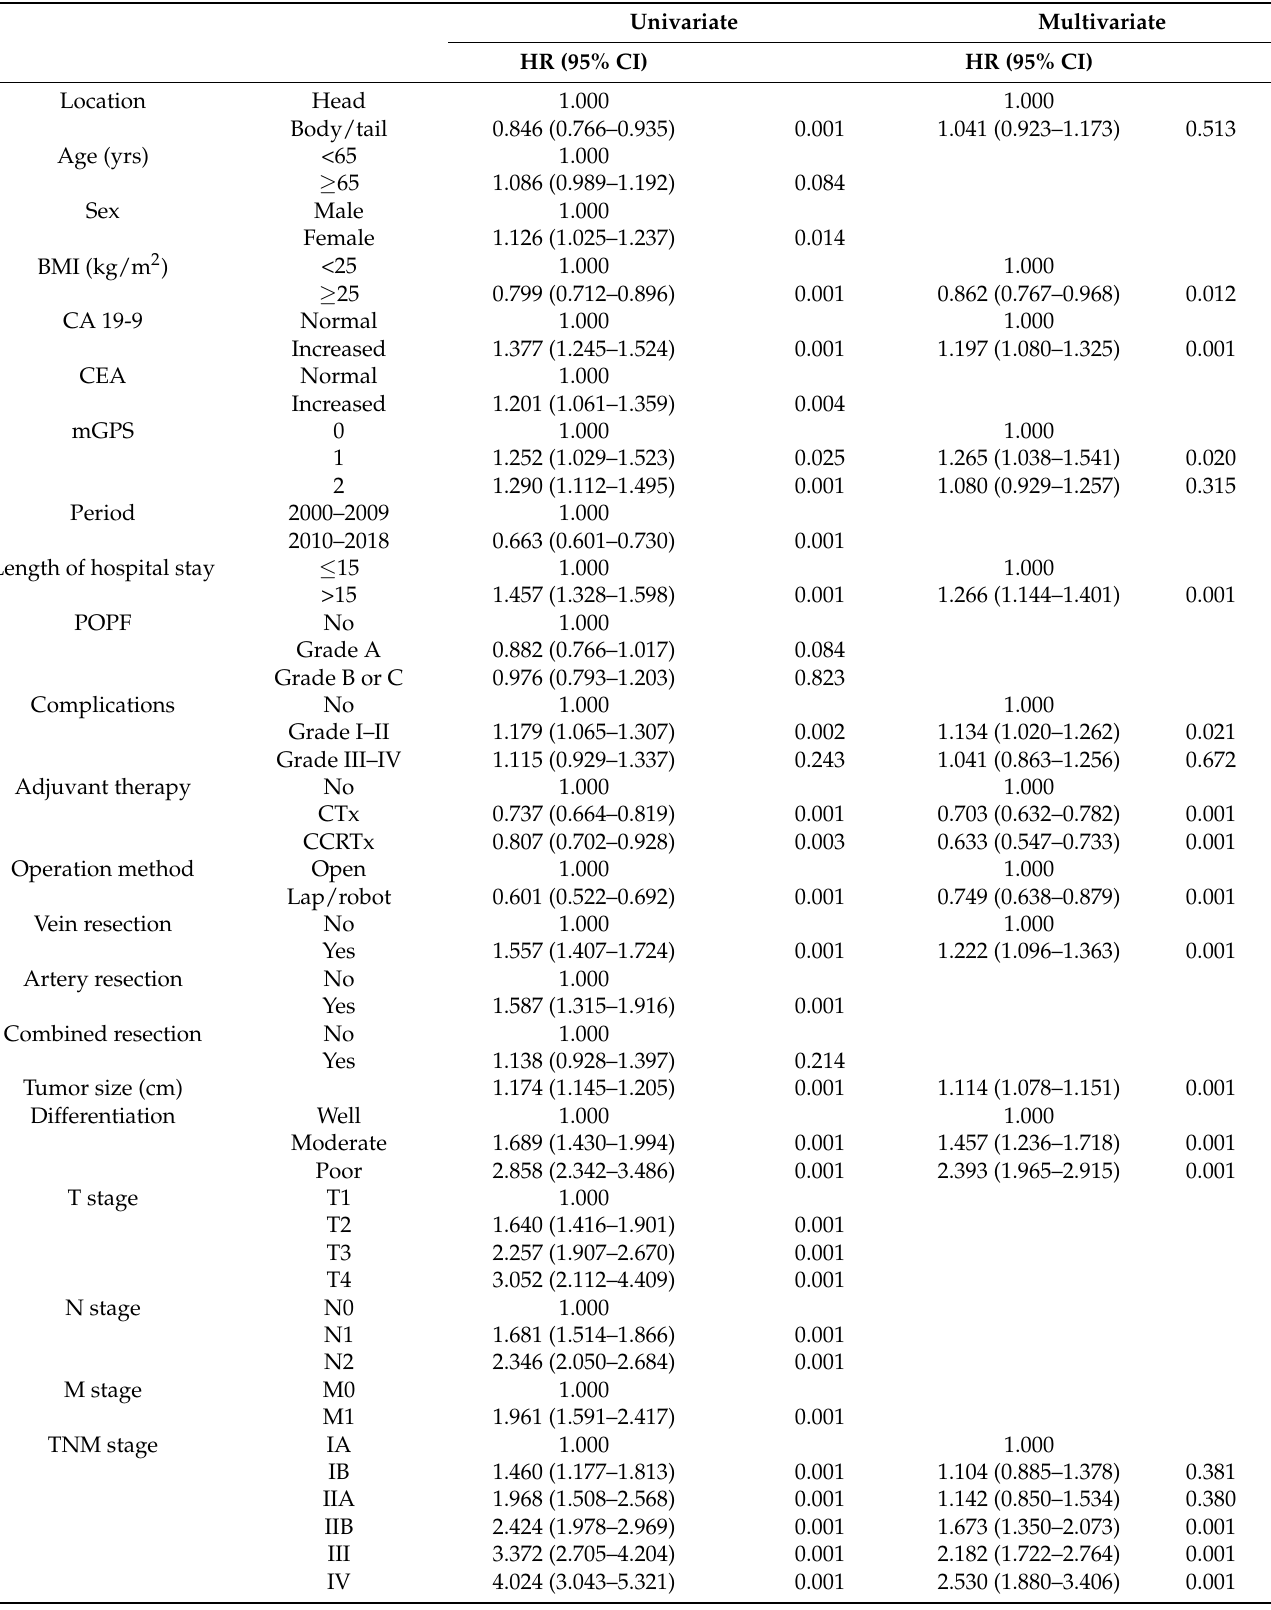
Table 3. Multivariate analysis for predictive factors of overall survival of pancreatic ductal adenocarcinoma